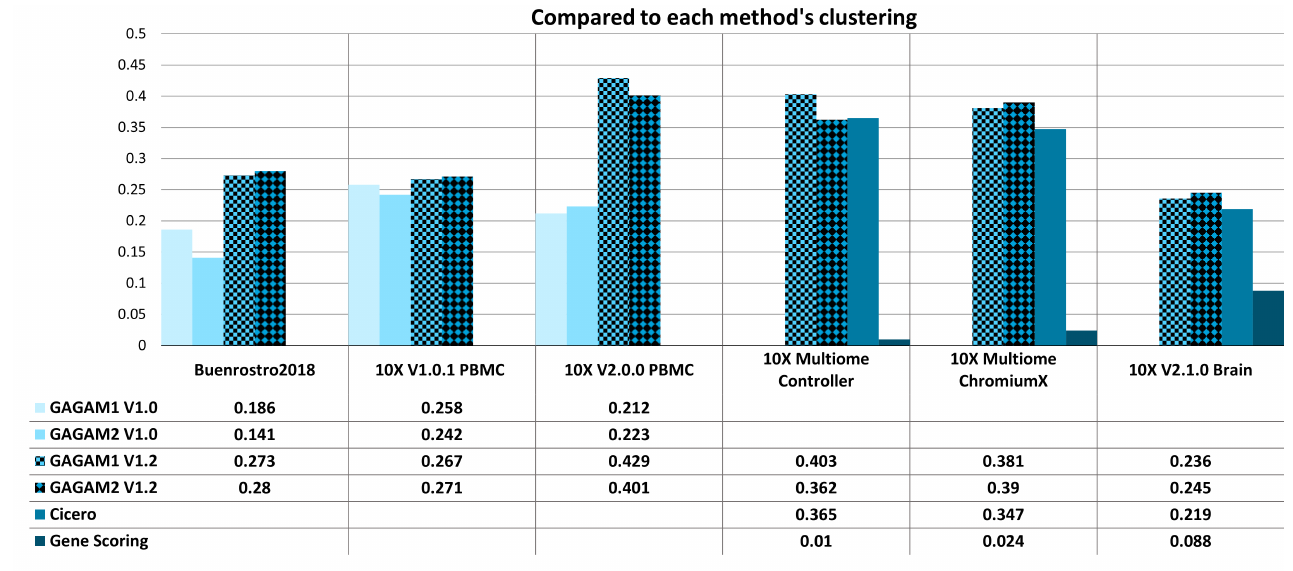
Figure 7. RAGI results of both Old ( left ) and New ( right ) datasets when compared to each method’s clustering. The Old datasets are compared with the previous GAGAM v1.0 from [10], while the New datasets are with Cicero and